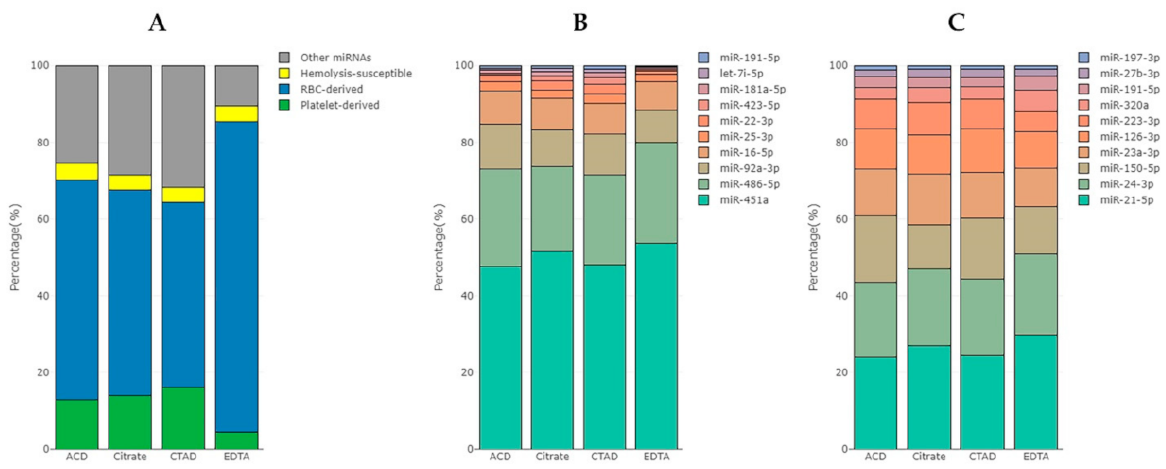
Figure 8. The percentage of RBC-derived, platelet-derived and hemolysis-susceptible miRNAs in the study groups. ( A ) Distribution among all miRNA reads. ( B ) Distribution among the top 10 RBC-derived miRNAs. ( C ) Distribution among the top 10 platelet-derived miRNAs. The percentage was calculated based on the TMM-normalized CPM